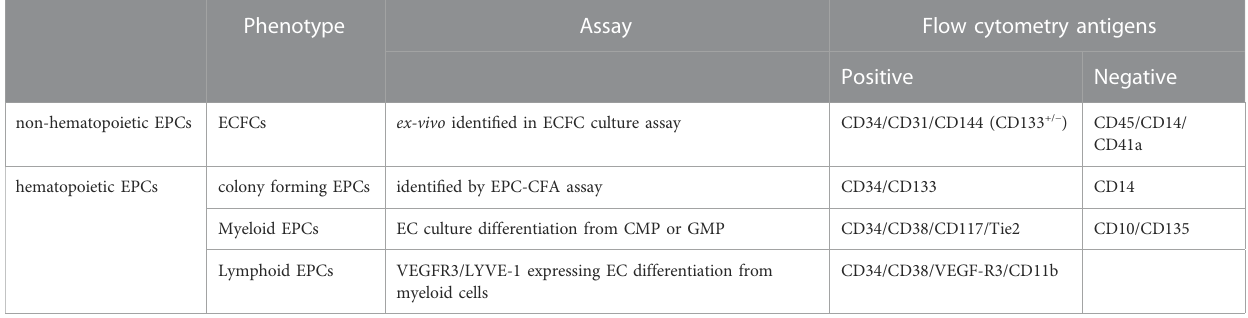
TABLE 1 Phenotypes of CD34 +